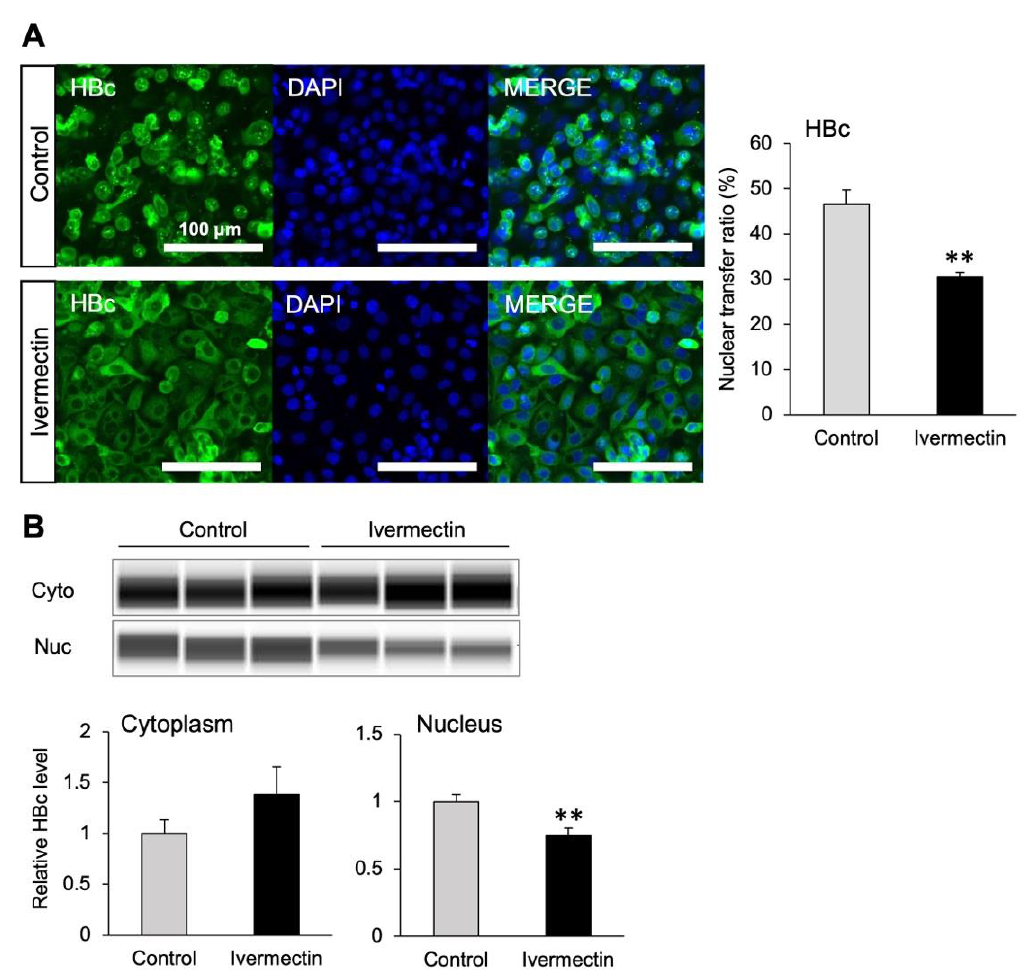
Figure 4. Ivermectin decreased HBc entry into the nucleus. ( A ) Distribution and percentage of HBC-positive cells in the nucleus 48 h after HBc transfection. HepG2-hNTCP-C4 cells were treated with 5 µ M ivermectin or 0.1% DMSO (vehicle control) from 24 h before to 48 h after HBc transfection. ( B ) Quantification of HBc expression in the nucleus and cytoplasm of HepG2-hNTCP-C4 cells at 48 h after HBc transfection. HepG2-hNTCP-C4 cells were treated with 5 µ M ivermectin or 0.1% DMSO (vehicle control) from 24 h before to 48 h after HBc transfection. Expression was corrected for the total protein levels of each sample. In the graphs, the protein expression of the control is defined as 1. Data are presented as the mean ± SD ((A), n = 4; (B), n = 3). ** p < 0.01.